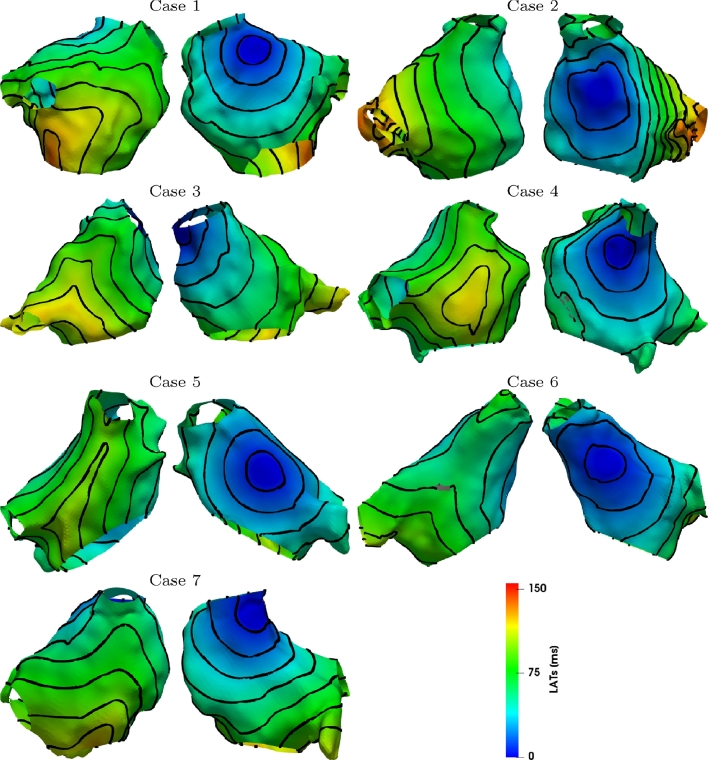
LATs evaluated by numerical simulations when s2=343ms and stimulus is applied at HRA. Isochrones are equally spaced with 10 ms intervals.